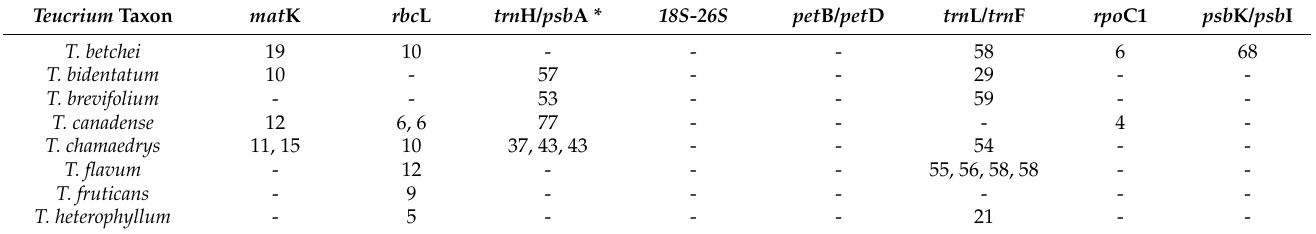
Table 2. DNA sequence analysis and contrast of Teucrium luteum subsp. gabesianum with other Teucrium species and subspecies based on eight molecular markers. Different records indicate the number of detected nucleotide differences (including gaps) compared to DNA sequences of T. luteum subsp. gabesianum . Multiple numbers in columns show variation in detected genetic differences between different accessions available in